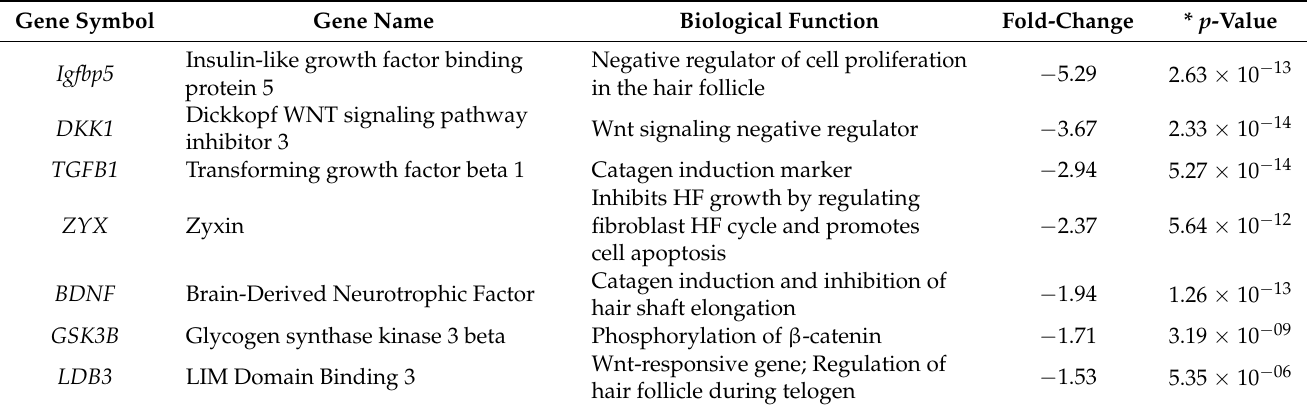
Table 4. Summary of the top downregulated hair growth-associated genes by